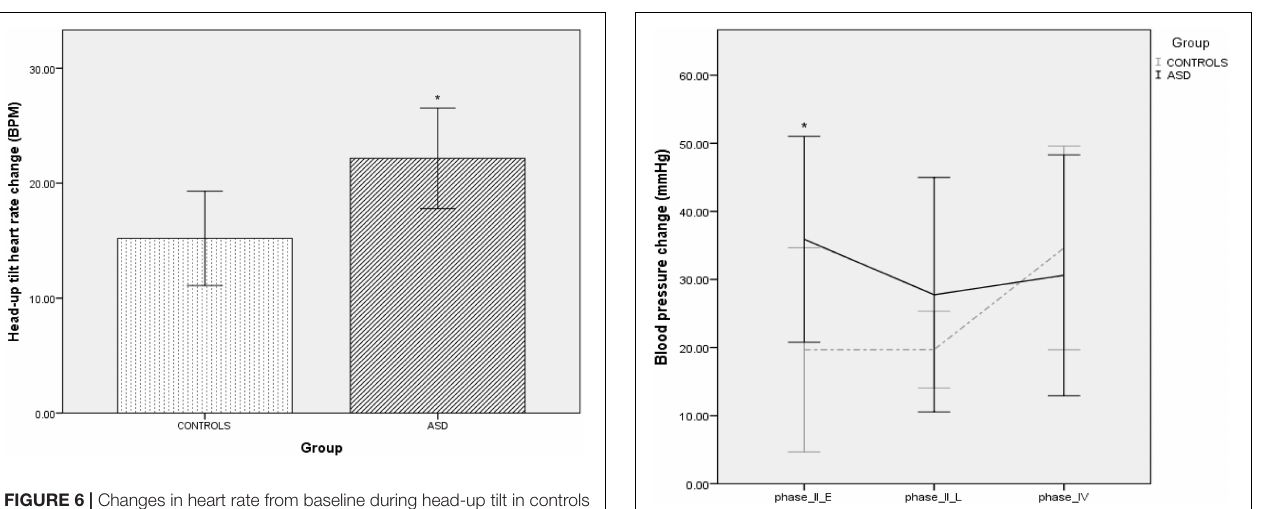
FIGURE 7 | Blood pressure profiles during the Valsalva maneuver in controls and ASD. mmHg, millimeters of mercury. *Refer to a statistically significant